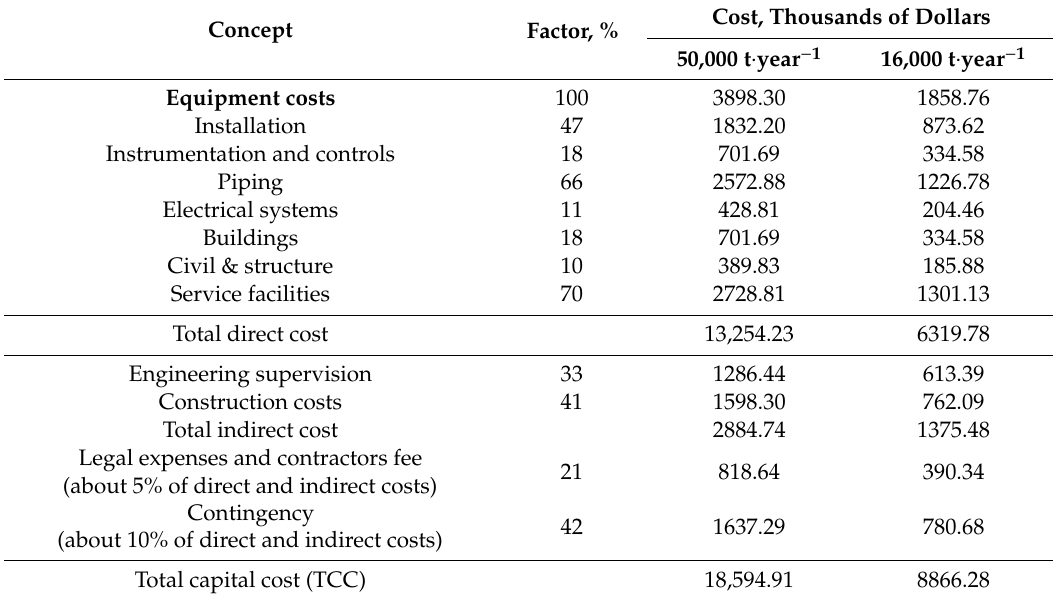
Table 8. Estimated fixed capital cost (year 2015).